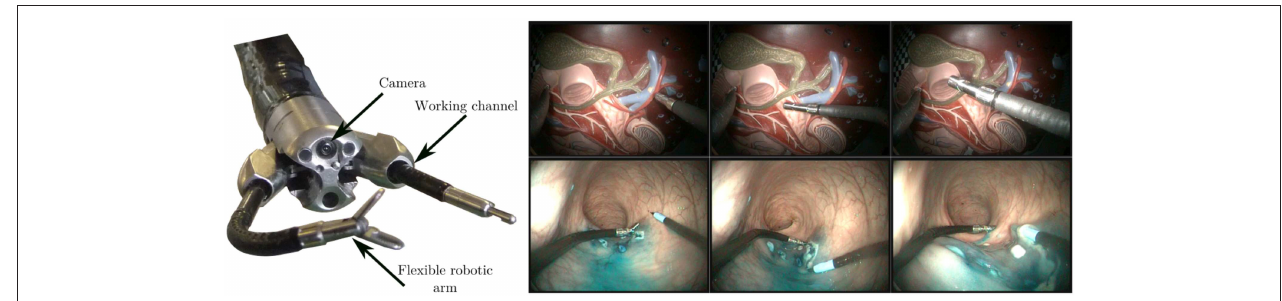
FIGURE 7 | (Left) View of the tip of the STRAS robot, showing the endoscopic camera, the deploying working channels, and the flexible robotic arms. (Right) Sample images from the lab (top row) and in vivo (bottom row) datasets, featuring robot and environment movement, as well as tool/tissue interaction. Note that the visual appearances of the instruments are significantly different between both